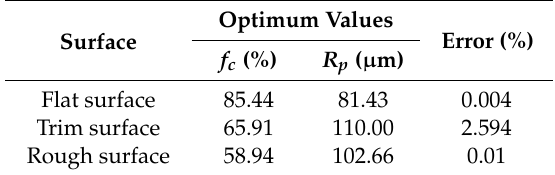
Table 7. Optimumvaluesof R p and f c asobtainedbyminimizingerrorforworkpiecesofvaryingroughness.